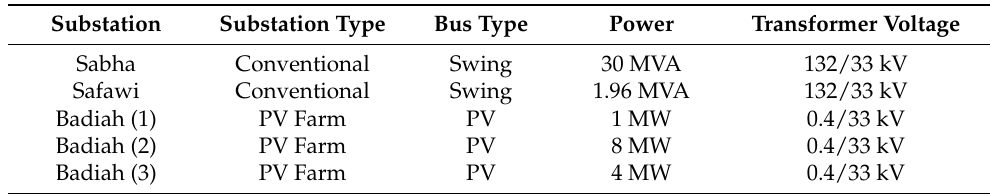
Table 2. Substations data in JSDN.